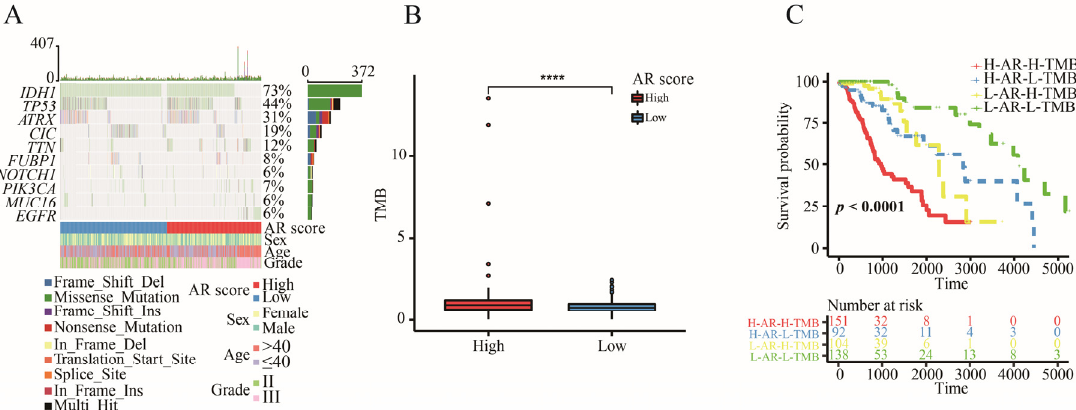
Figure 6. The somatic mutation analysis. ( A ) The waterfall diagram of top 10 driver genes. ( B ) The level of TMB between high- and low-AR groups. ( C ) Kaplan–Meier survival analysis of OS for LGGs stratified by both TMB and AR score. Data in ( B ) was analyzed by Wilcoxon test; **** p < 0.0001.